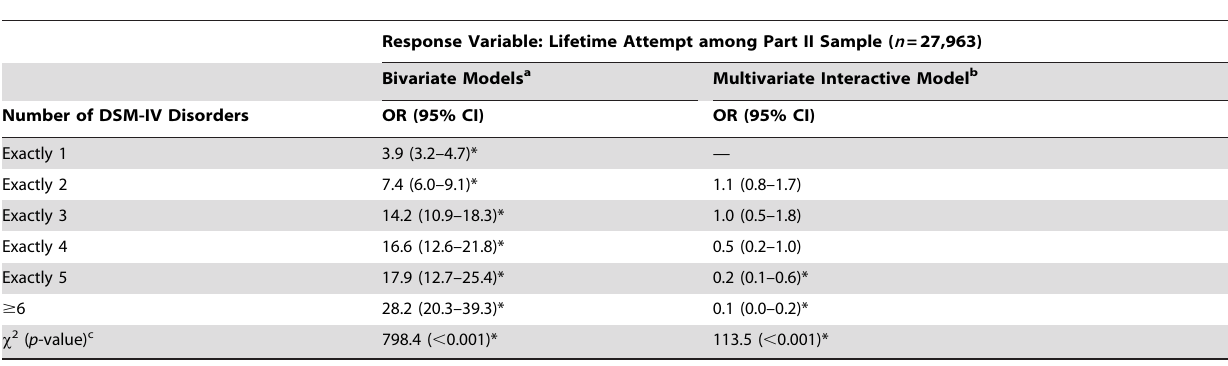
Table 4. Survival models of the associations between number of prior DSM-IV disorders and a subsequent suicide attempt— developed countries.